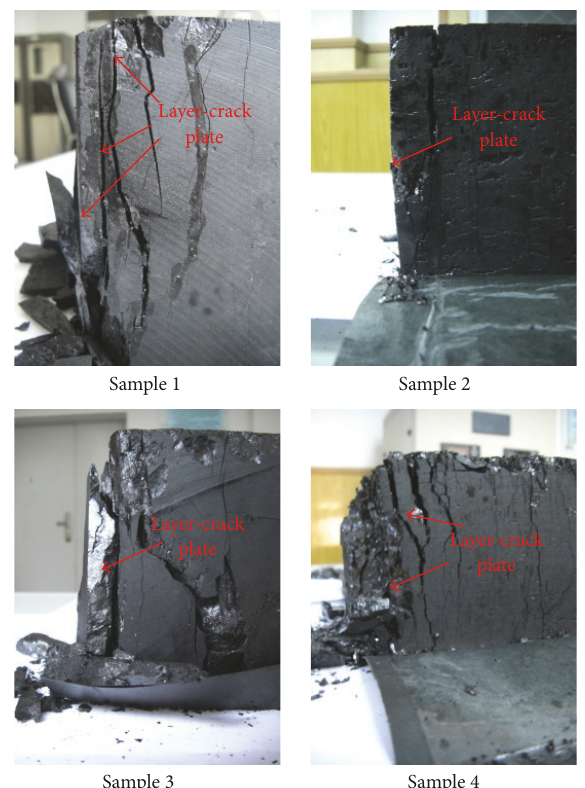
Figure 9: Characteristics of the layer-crack plate structures in the coal